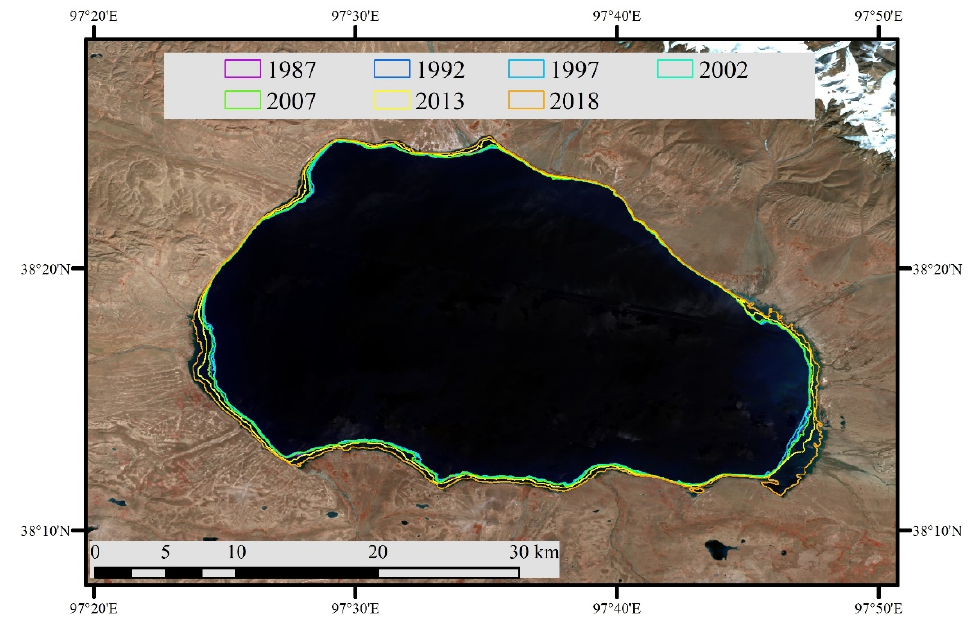
Figure 3. The changes in the shorelines of Hala Lake during 1987–2018.